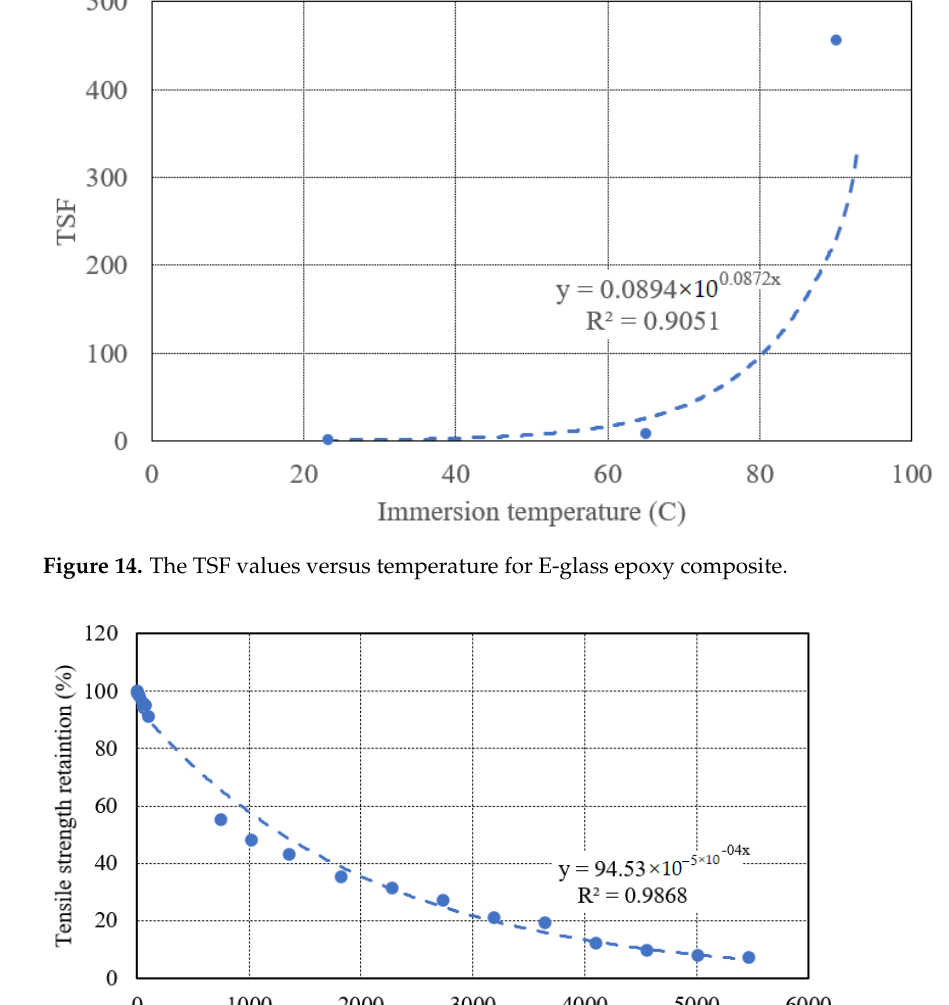
16 of 21 Figure 13. Tensile strength retention of E-glass epoxy samples exposed to seawater at 23 °C, 65 °C, and 90 °C. Table 6. Coefficients of regression equation. Temperature